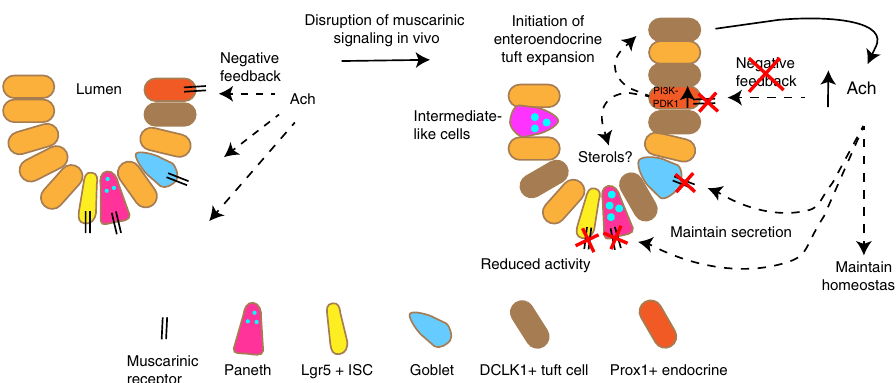
Fig. 7 Model summarizing the importance of the cholinergic intestinal niche to maintain epithelial homeostasis. Prox1-positive endocrine cells respond to a loss of negative feedback upon M3R ablation, which results in the expansion of an enteroendocrine tuft cell phenotype and sustained cholinergic